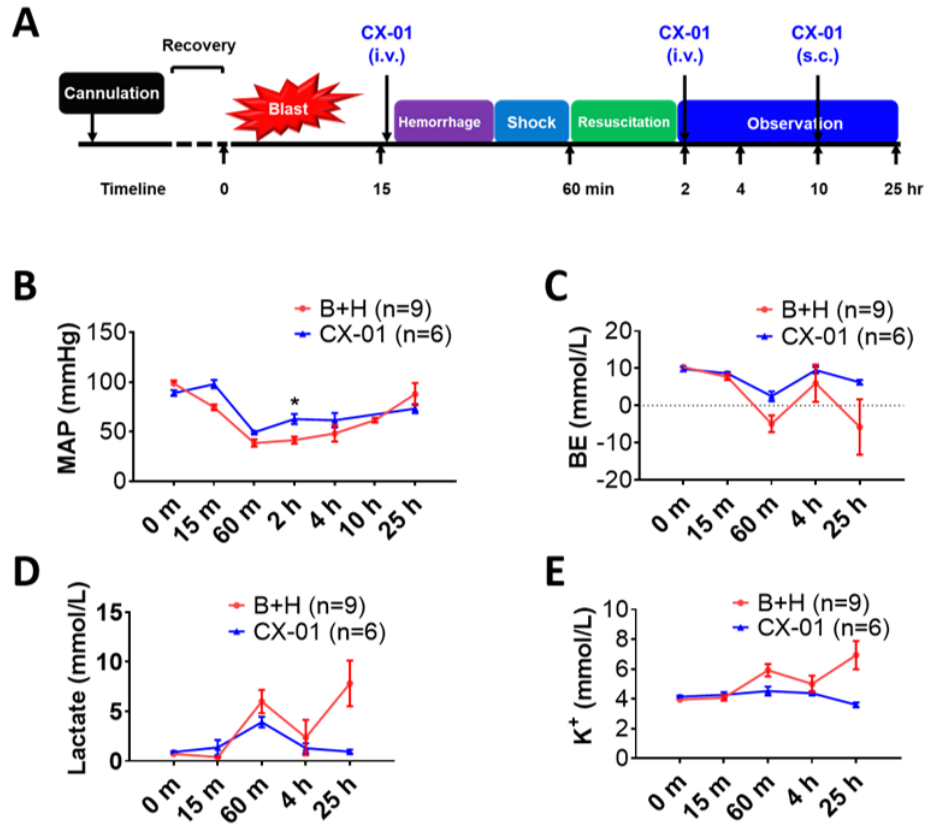
Figure 4. Effects of CX-01 treatment on MAP, and blood chemistry changes in the rat model of TH. ( A ) Experimental design. Experimental groups: (1) B + H = blast overpressure + hemorrhagic shock; (2) CX-01-treated injured rats. As marked in ( B ) changes of MAP were monitored via the carotid artery by the BIOPAC system and the changes were recorded throughout the study. During shock and resuscitation period, the MAP was recorded every 5 min; ( C ) BE/BD; ( D ) lactate; and ( E ) potassium plasma concentrations are given. Data are presented as mean ± SEM. The individual time points were compared using the unpaired t -test with Welch’s correction, and comparison of the groups was performed by two-way ANOVA. * = p < 0.05 Labels: MAP = mean arterial pressure; BE/BD = base excess/base deficit; K + = ionized potassium.